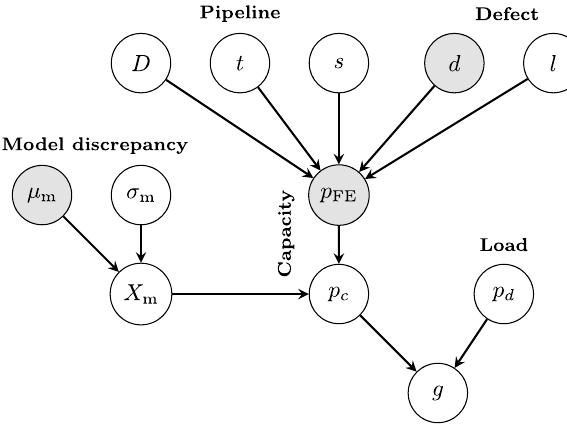
Fig. 2 Graphical representation of the corroded pipeline structural reliability model. The shaded nodes d , p FE and 𝜇 m have associated epistemic